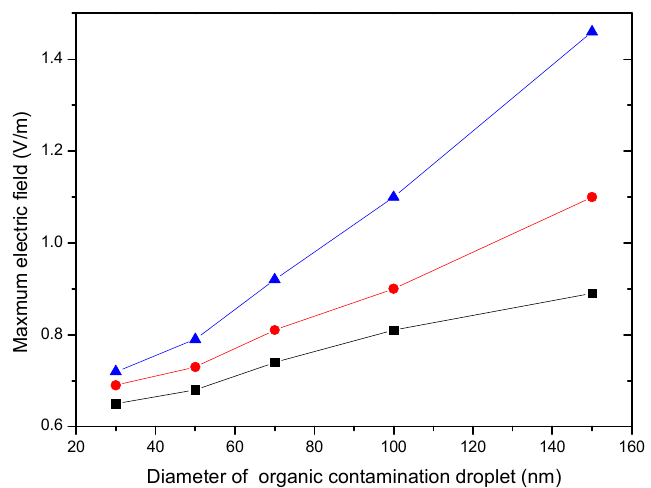
Figure 4. Light field variation with organic contamination droplets of different sizes. The blue, red, and black lines are the result of the different refractive indexes (1.5, 2.6, and 2.2, respectively) of the defect.